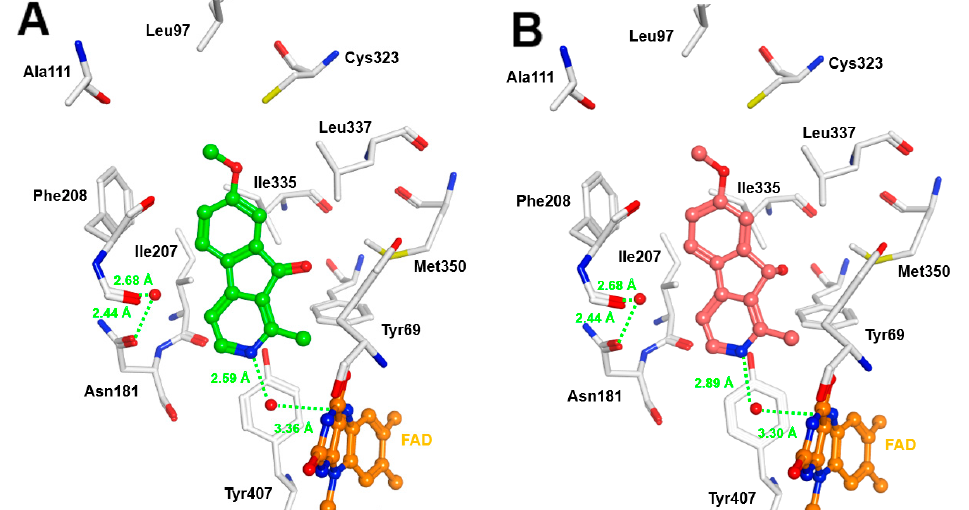
Figure 8. 9-Desazaharmine analogues ( A ) AnnHT2 (carbon atoms in green) and ( B ) AnnHT3 (carbon atoms in brown; S enantiomer shown) docked into MAO-A (PDB 2Z5X). Oxygen atoms in red, nitrogen atoms in blue, water molecules shown as red balls.